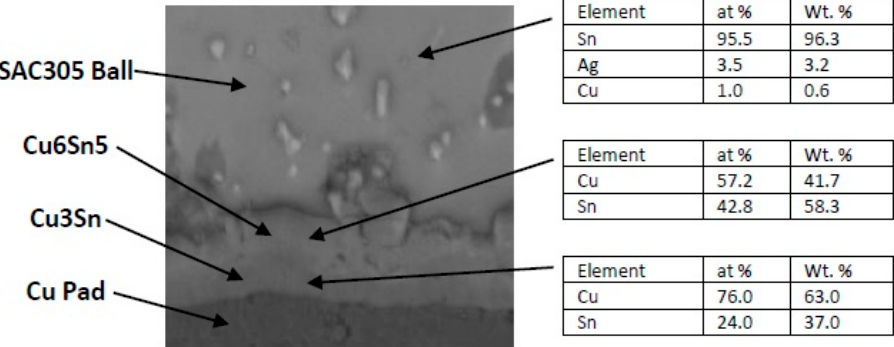
Figure 10. EDAX analysis at select locations on the SAC305/copper interface.